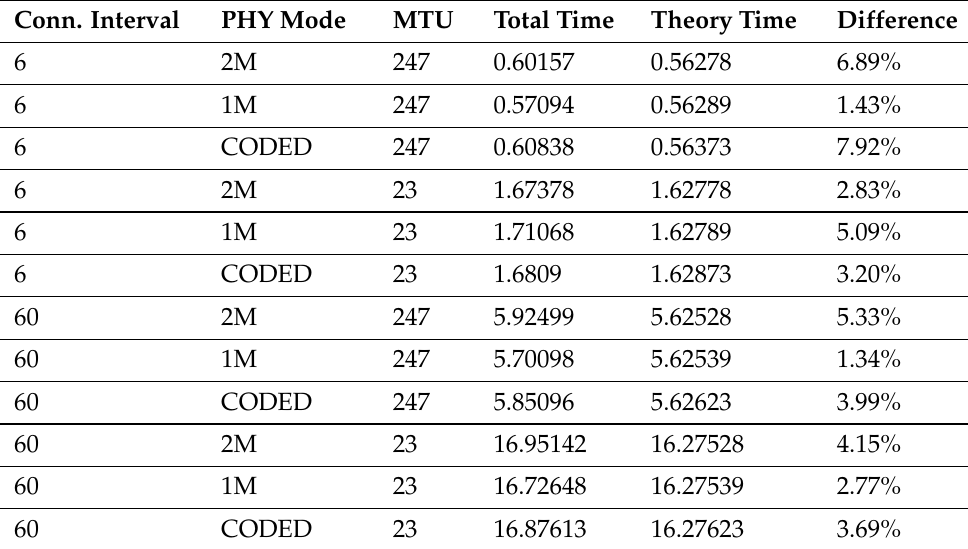
Table 3. Device 2 comparison practice to theory. Conn.